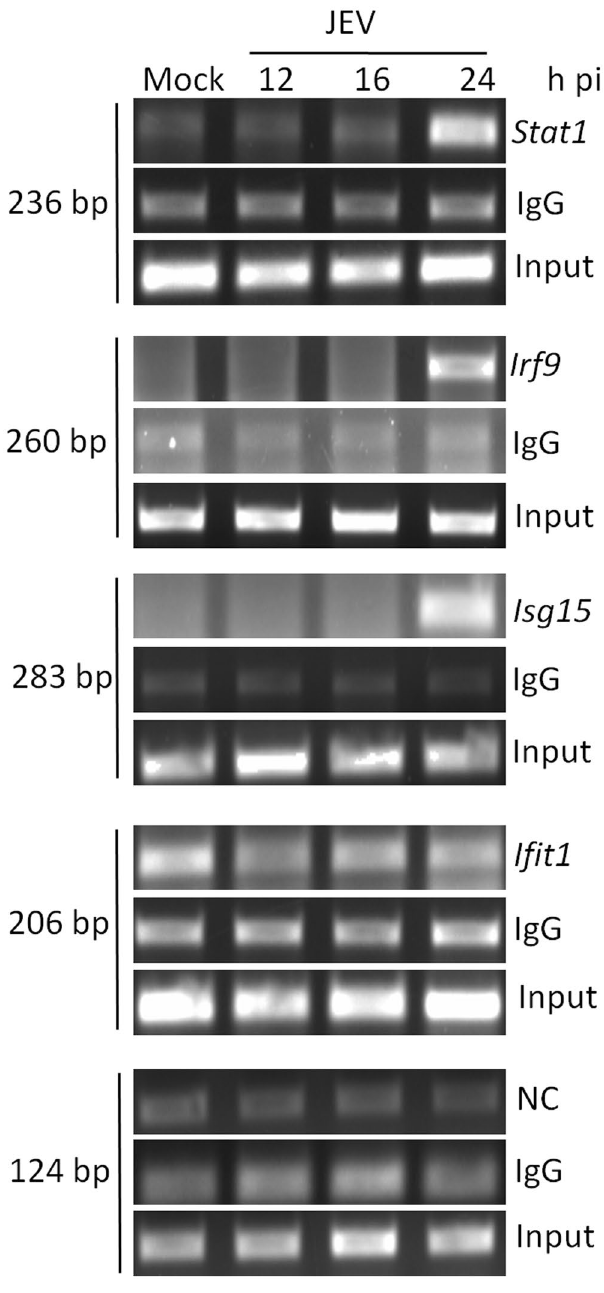
Figure 4. ATF3 binding to the promoter region of different antiviral genes. Neuro2a cells were mock-infected or infected with JEV (MOI 5) and at different time points chromatin immunoprecipitation was performed using ATF3-specific rabbit antibody or rabbit IgG (negative control for pull-down). Gene promoter-specific DNA was PCR amplified and separated on a 2% agarose gel. The relative abundance of pulled-down DNA during JEV infection as indicated by the PCR product is shown. The experiment was performed twice, and a representative figure is shown. NC indicates the negative control to rule out the enrichment of DNA due to the non-specific binding to beads. Here, oligonucleotide primers derived from the mouse gene desert were used. Ten percent of total lysate was used as